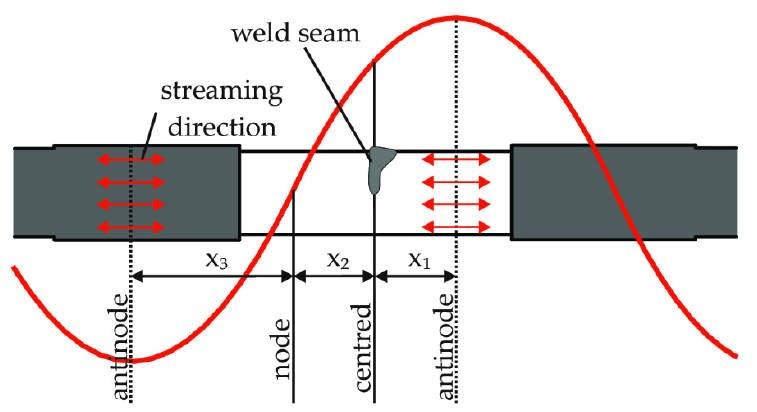
Figure 1. Influence of the wave-position on the weld seam.